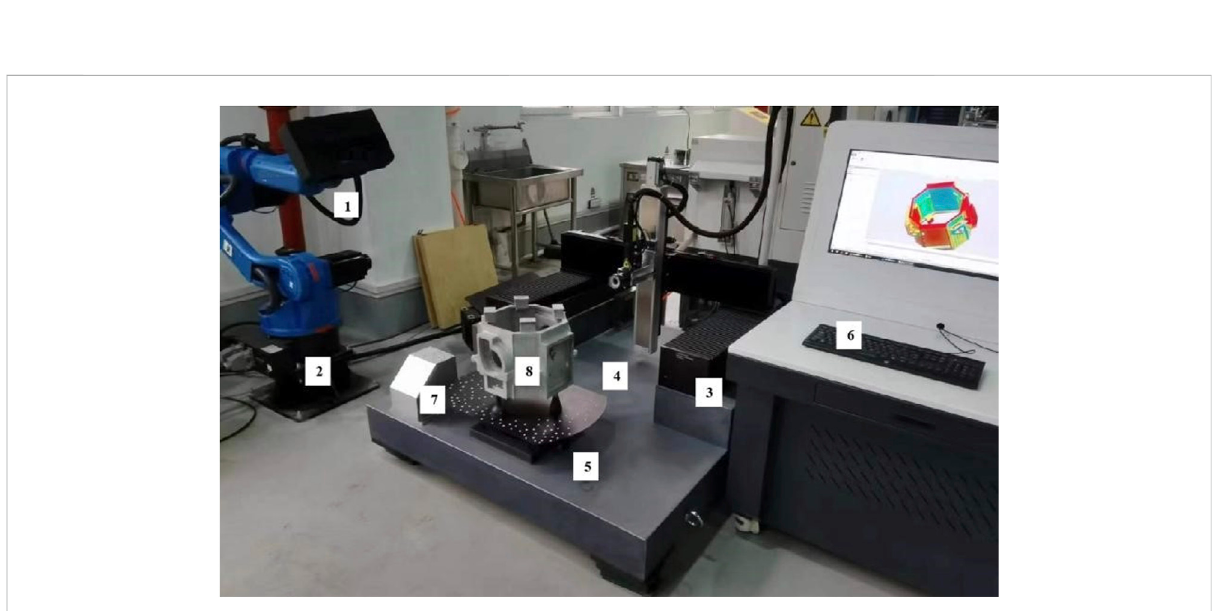
FIGURE 7 3D measurement and scribing platform. It primarily comprises the following components: 1) automatic 3D measurement sensor, 2) 6-DOF robot, 3) high precision motion mechanism, 4) laser scribing equipment, 5) turntable, 6) Data Processing Computer, 7) fi xed calibration target and 8) workpiece.